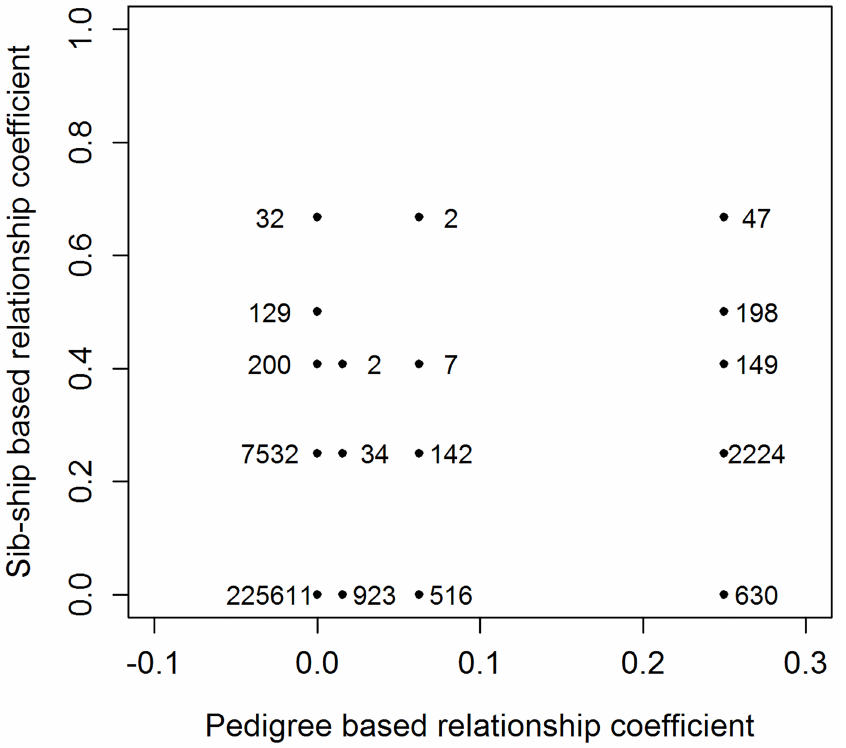
Fig 2. Relatedness agreement. Agreement in relatedness inferred from the pedigreeand from sib-ship analysisand numberof cases detected are given in the lower triangularrelationshipmatrix (including diagonal)for each